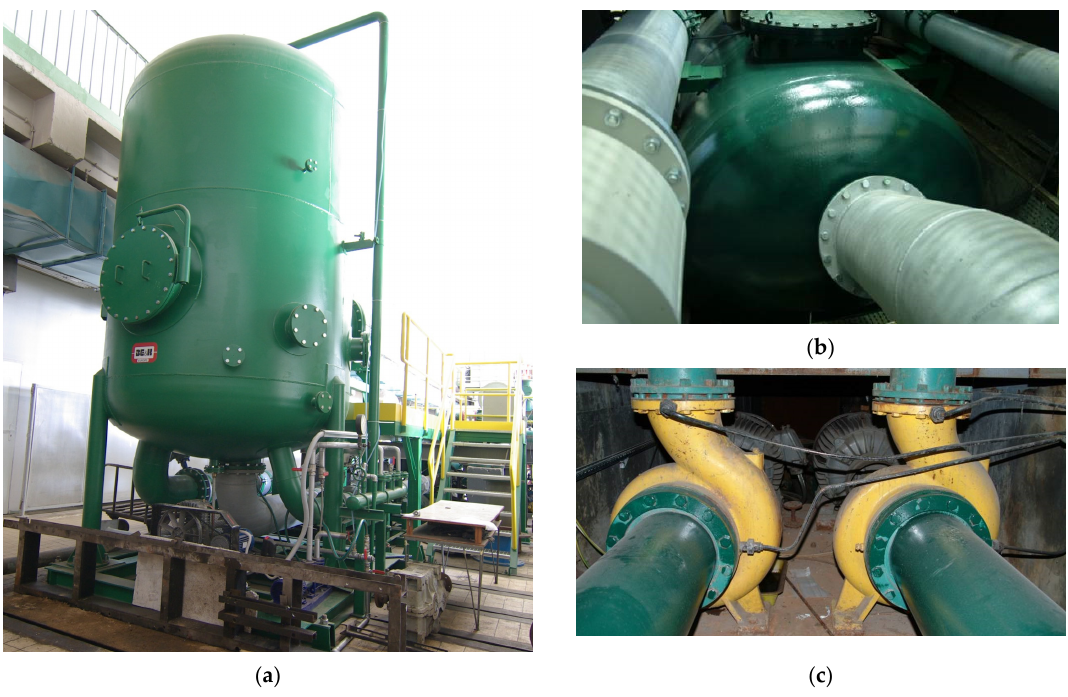
Figure 12. Laboratory stand for testing hydraulic turbines, located in the laboratory of IFFM in Gda ń sk, Poland; ( a )—view from the upper water tank side; ( b )—bottom water tank; ( c )—circulation pumps and their motors.